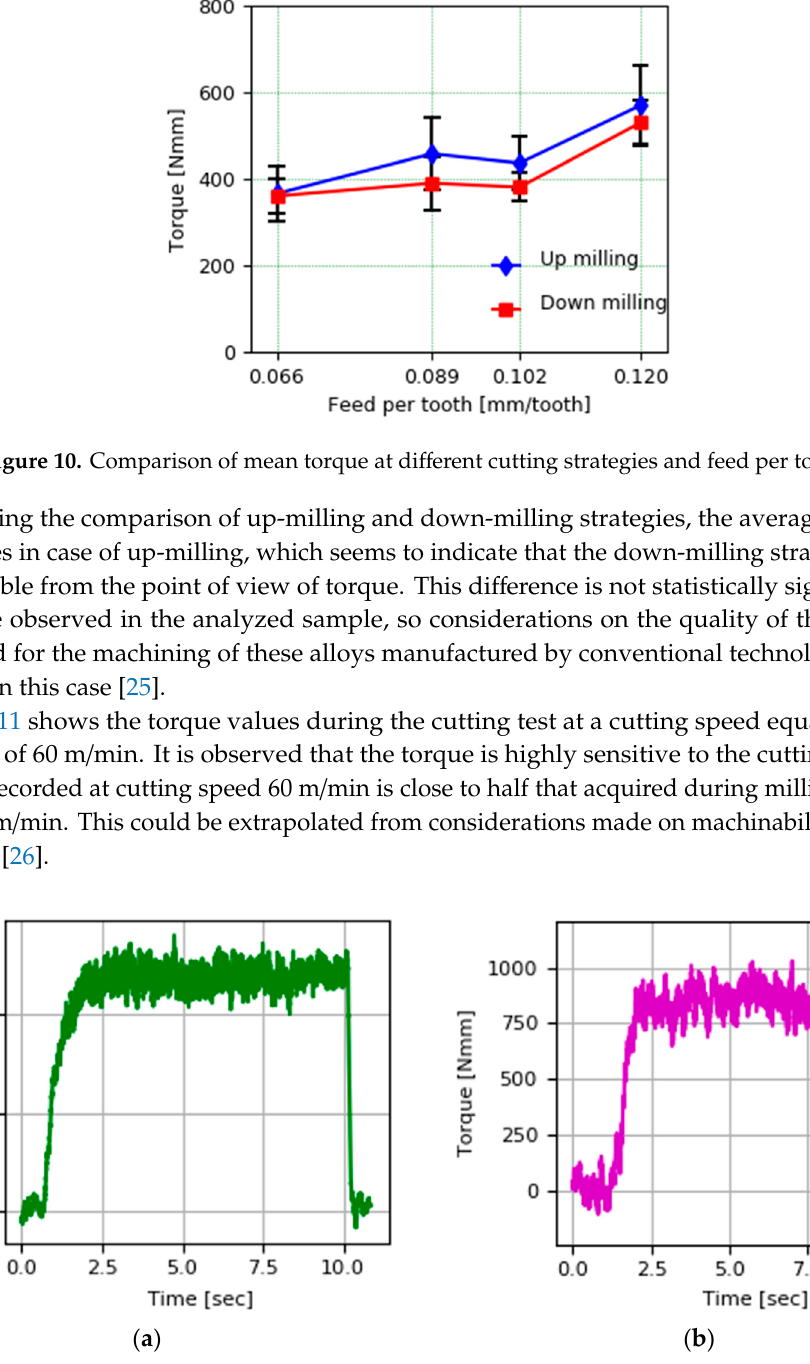
Figure 12. Torque comparison on cutting PAW-WAAM wall at different Z tool positions from 5 mm to 25 mm. 3.3. Surface Quality In this section, the surface quality results of the piece are analyzed in the different tests carried out based on the surface roughness measured in the PAW-WAAM mechanized wall. Figure 13 shows the average roughness values at different feed rates per tooth in face milling in both up milling and down milling. In order to obtain the average roughness, three measurements of the profile of the two mechanized walls have been made first with each set of conditions, from each of which the arithmetic average of the absolute values of the roughness (Ra) has been extracted. The roughness values are typical of the finishing pass with an adequate magnitude. These values allow